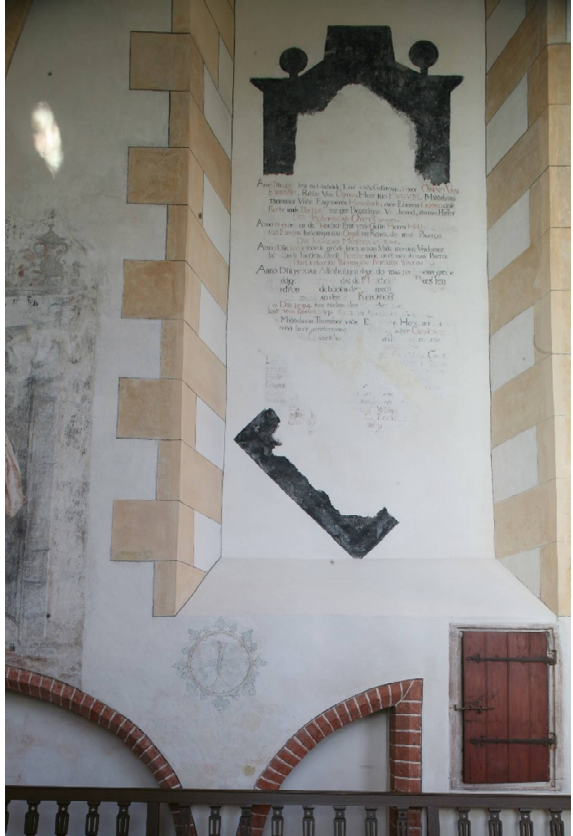
Figure 10. Middelstum (Groningen), 17th-century church chronicle painted on the north wall of the chancel above a late medieval Sacrament niche (photo: Regnerus Steensma archive).